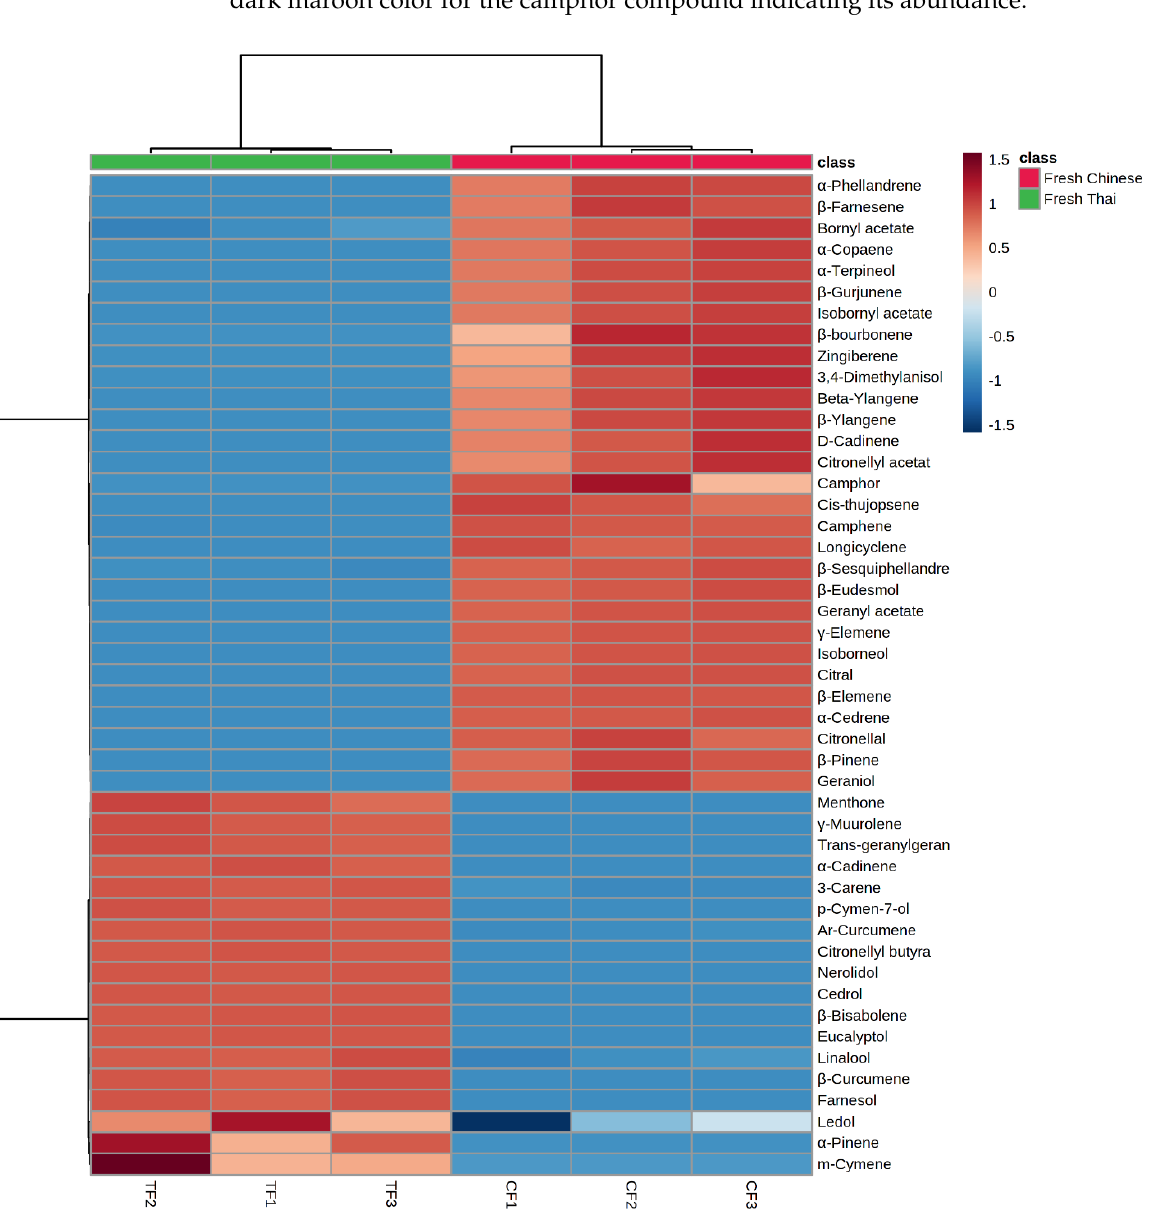
Figure 4. Heat maps showing the major class of compounds in both fresh Chinese and fresh Thai